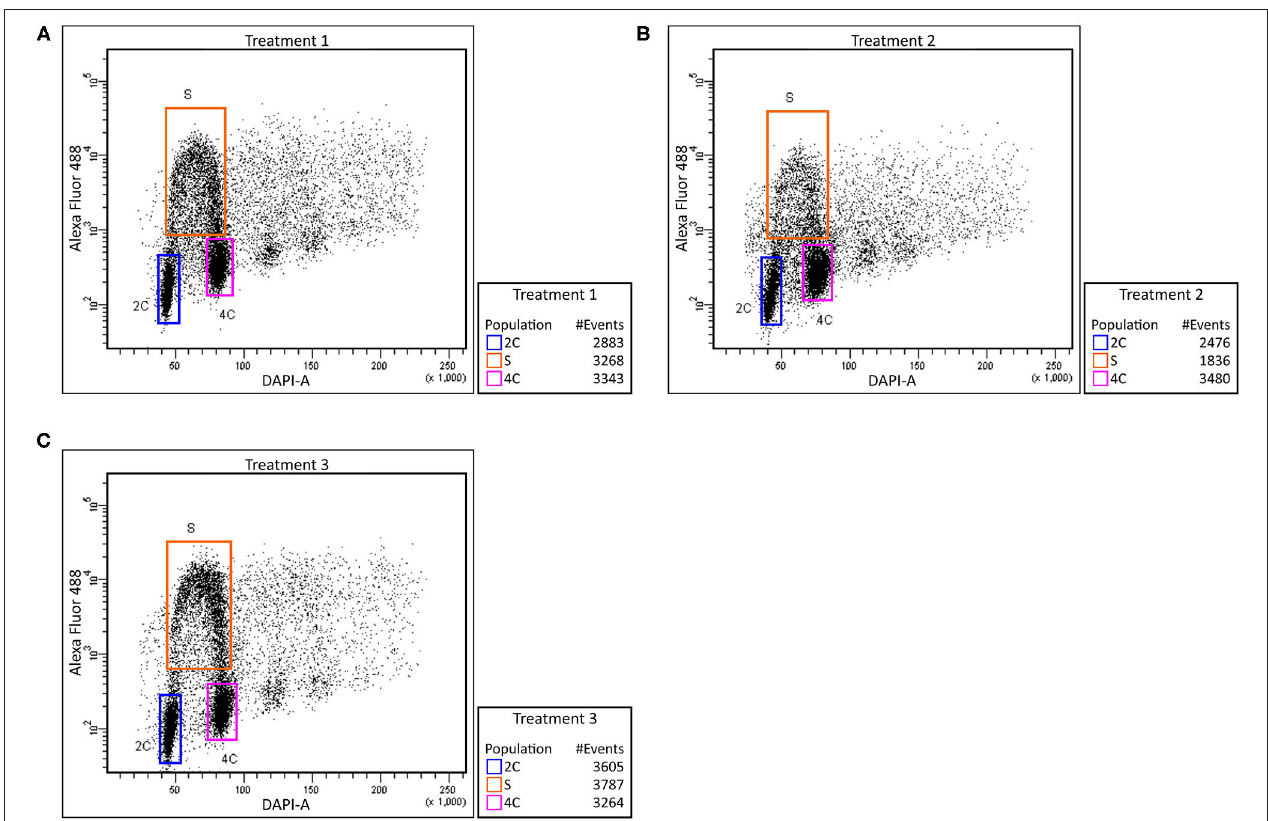
FIGURE 2 | Effect of cadmium on root cell cycle. Barley root tip cells were labeled with EdU and analyzed using flow cytometry. Control plants (no added Cd)–Treatment 1 (A) , plants treated with Cd–Treatment 2 (B) , and plants washed and grown in control media after Cd exposure–Treatment 3 (C) . Relative DNA content was measured using DAPI (X-axis) and extent of proliferating nuclei was measured by means of EdU incorporation based on Alexa Fluor 488 fluorescence (Y-axis). Regions of replicating (orange) and non-replicating (blue and purple) nuclei are